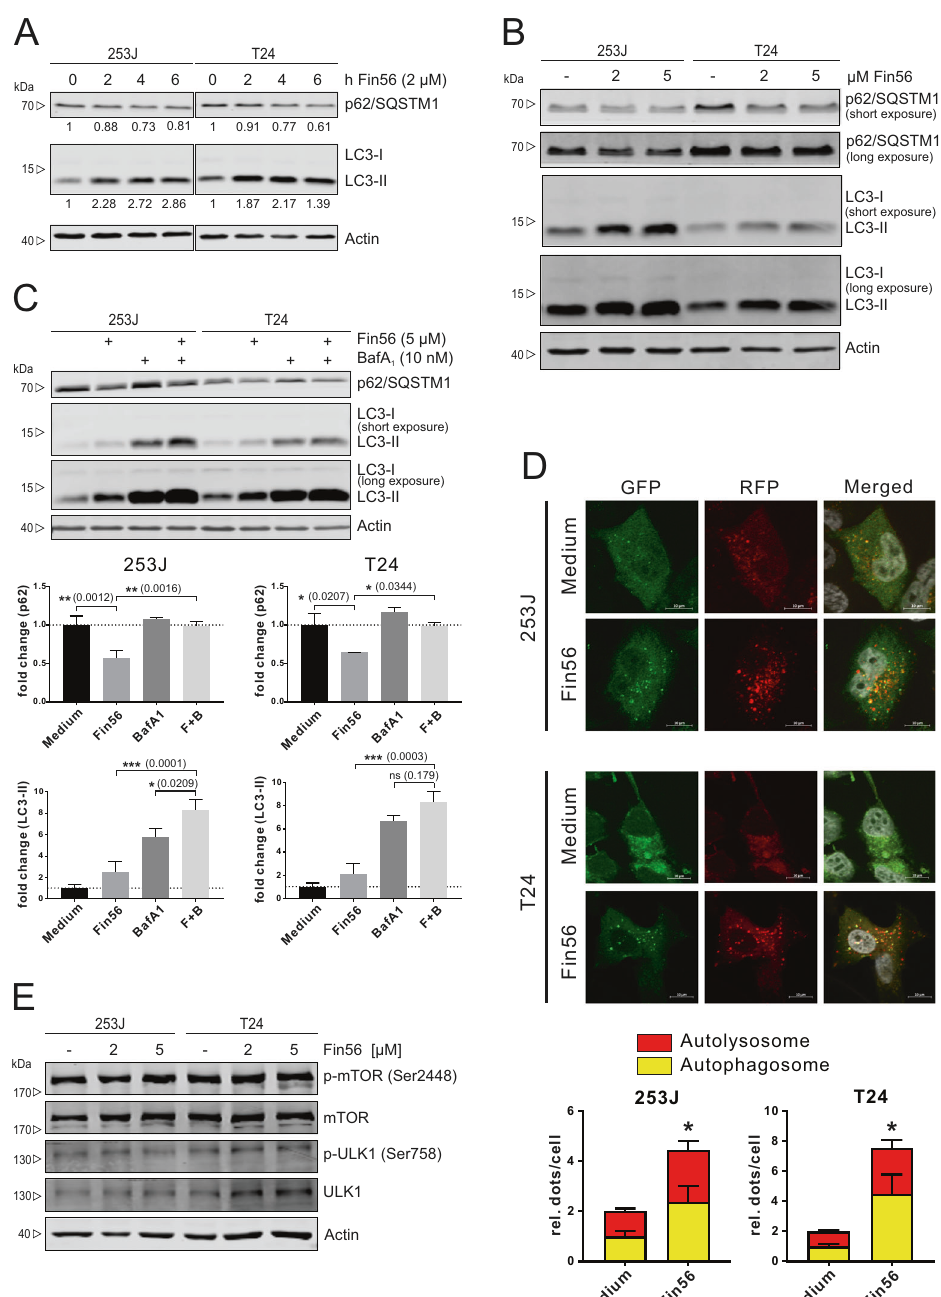
Fig. 3 Fin56 induces autophagy in bladder cancer cells. A 253J and T24 cells were treated with 2 µM Fin56 for 0, 2, 4, or 6 h. After incubation, cells were lysed and cellular lysates were immunoblotted for the indicated proteins. One representative immunoblot is shown. The quanti fi cations are from two independent experiments. B 253J and T24 cells were treated with 2 or 5 µM Fin56 for 6 h. After incubation, cells were lysed and cellular lysates were immunoblotted for the indicated proteins. One representative immunoblot of three independent experiments is shown. C 253J and T24 cells were treated with Fin56 (5 µM), BafA1 (10 nM), or Fin56 + BafA1 (F + B) for 6 h. After the incubation, cells were lysed and cellular lysates were immunoblotted for the indicated proteins. One representative immunoblot is shown. The quanti fi cations of indicated ratios are from three independent experiments (means + SD). The respective P values are depicted in the diagram. D 253J and T24 stably expressing mRFP-EGFP-rLC3 cells were grown on glass coverslips one day prior to treatment. The following day, cells were treated with 2 µM Fin56 for 4 h and fi xed after treatment. Red puncta represent autolysosomes and yellow puncta represent autophagosomes. One representative image is shown. Scale bars are 10 µm. The quanti fi cations of puncta are from two independent experiments (means + SD); a minimum of 112 cells per stimulation was analyzed. The respective P values are depicted in the diagram (comparison of mRFP + EGFP + puncta between medium- and Fin56-treated cells). E 253J and T24 cells were treated with 2 µM or 5 µM Fin56 for 6 h. After the incubation, cells were lysed and cellular lysates were immunoblotted for the indicated proteins. One representative immunoblot of three independent experiments is